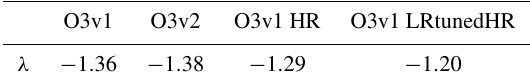
Table 3. Net climate feedback parameter ( λ , unit: watt per square meter per K) of different E3SM